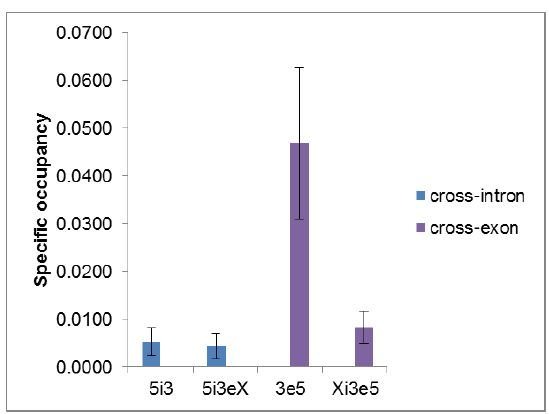
Fractional occupancy ( ± s.e.) of RNA molecules by U2 snRNP, averaged over the duration of the experiment.Data are from Figures 2I and 4C.